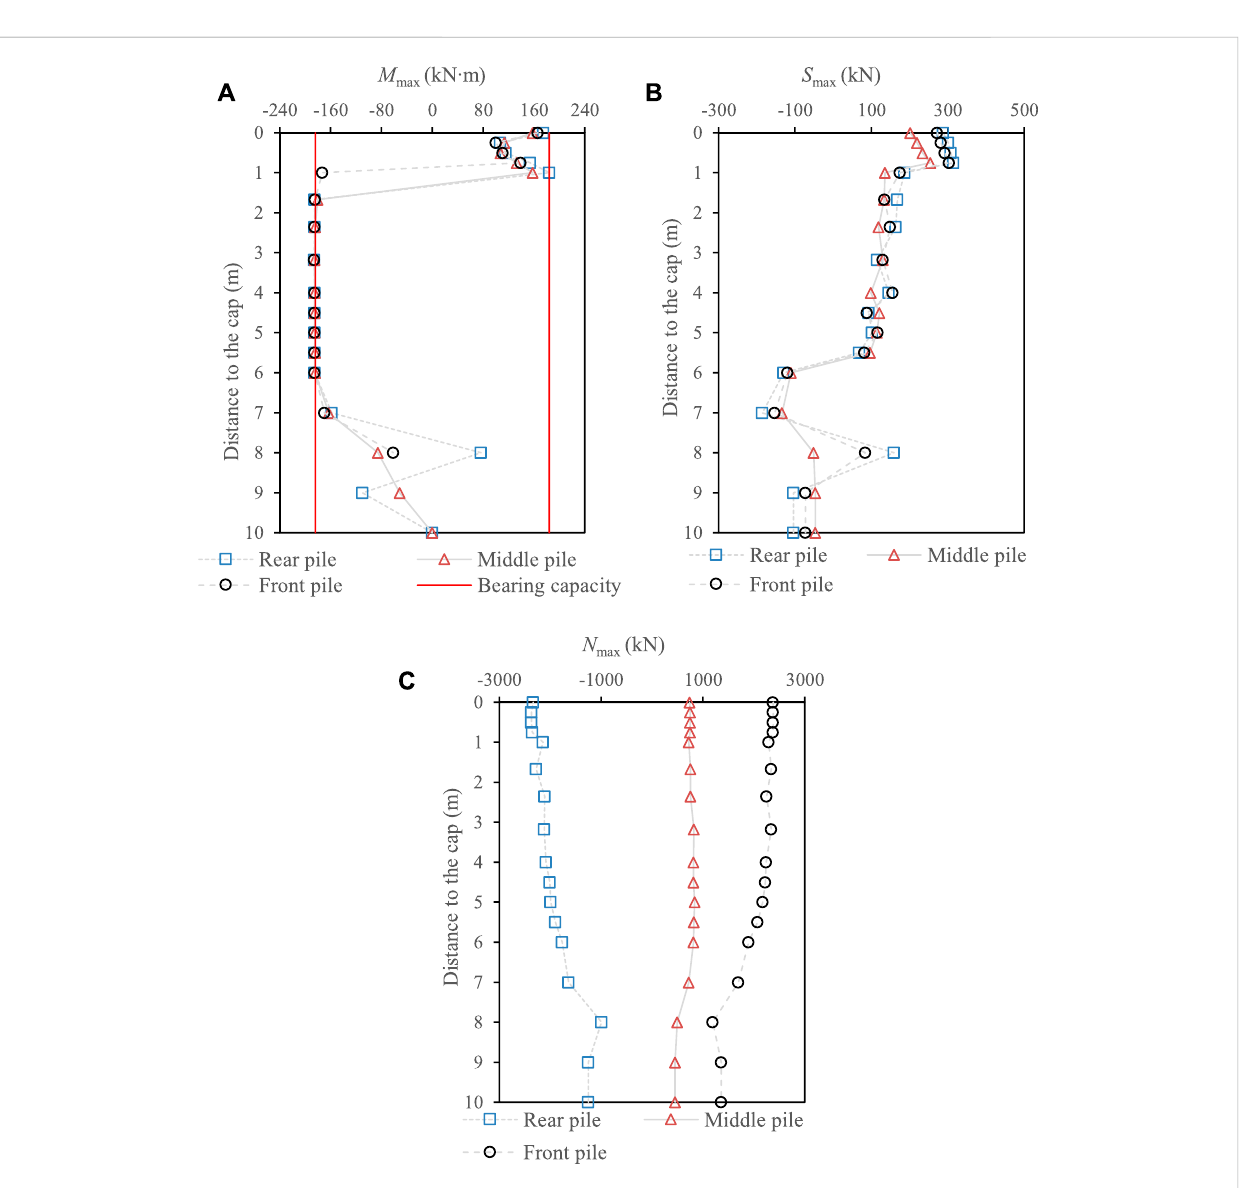
FIGURE 9 Distribution of the maximum internal force of a single pile at different rows (i.e., front, middle, and rear) (A) bending moment ( M max ), (B) shear force ( S max ), and (C) axial force ( N max ) (Case